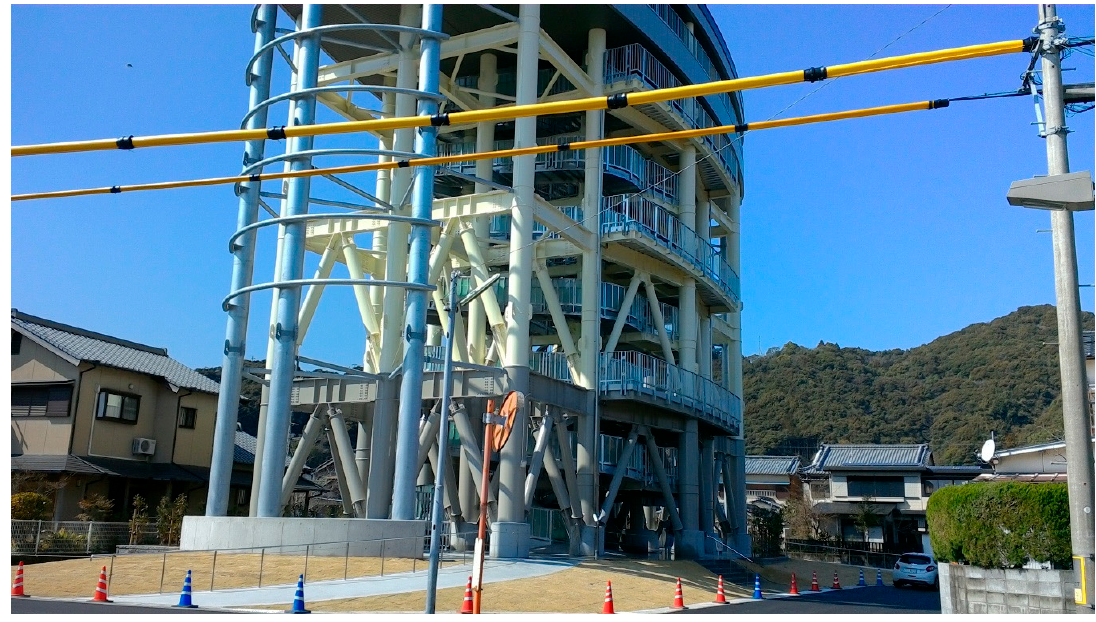
Figure 3. 22-metre high tsunami evacuation tower in Hamamachi Ward in Kuroshio Town.